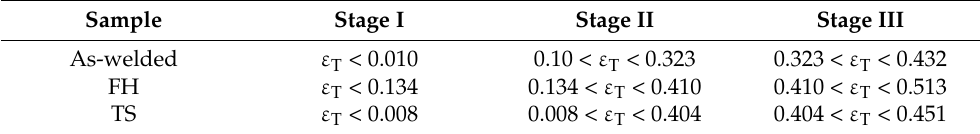
Table 4. The values of the true strains of each stage of the samples based on the C–J